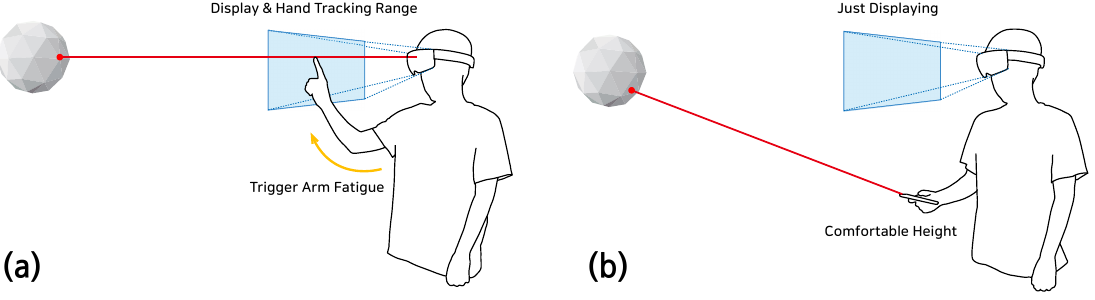
Figure 1. Hand Fatigue. ( a ) Previous HoloLens manipulation methods cause a lot of arm fatigue to the user. ( b ) The proposed interface does not need to raise the arm, so the user feels comfortable when manipulating the